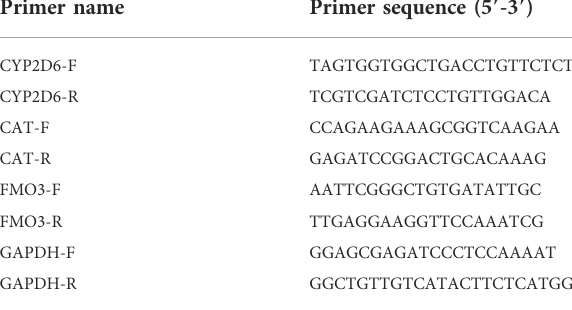
TABLE 1 Sequence of primers used in this